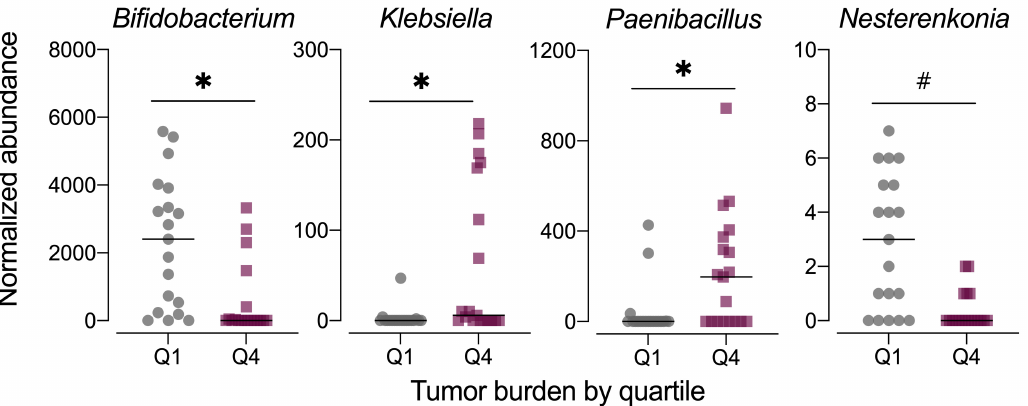
Figure 11 Figure 11. Normalized abundance of selected microbiota taxa at the genus level for samples segregated by tumor burden into quartiles. Values shown are the individual measurements for each animal in either the lowest quartile (Q1) or highest quartile (Q4) of tumor burden with the mean ± standard error ( n = 19/quartile). # indicates p < 0.10 for tumor burden stratified by quartile as determined by metagenomeSeq using a zero-inflated gaussian fit statistical model. Complete results for all taxa are provided in Table